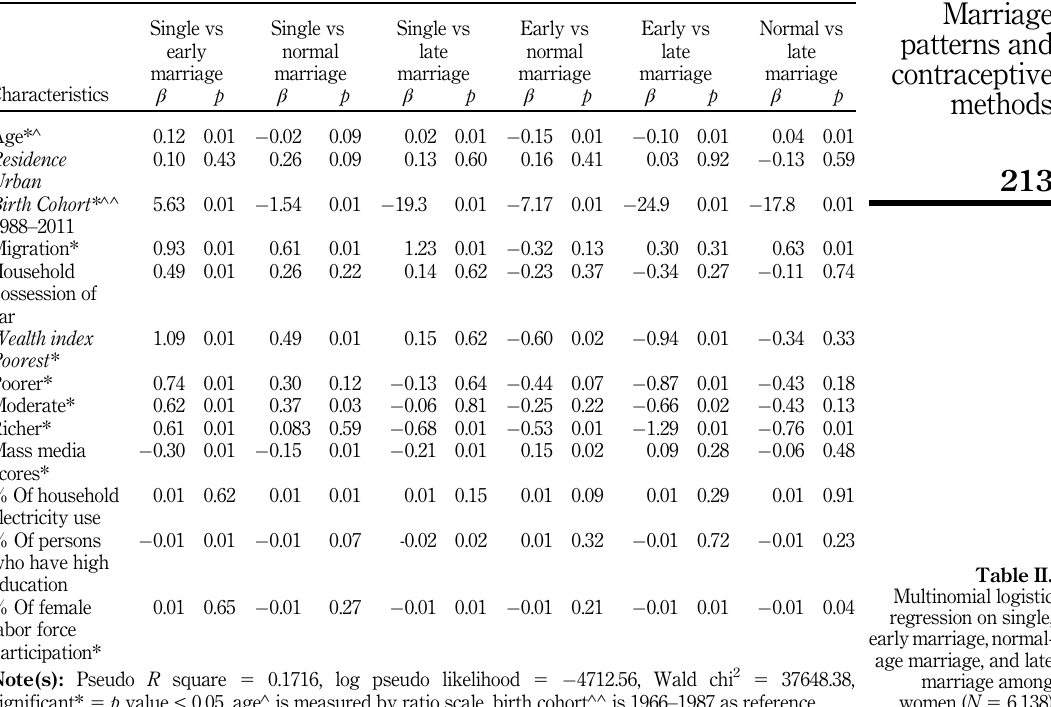
Table II. Multinomial